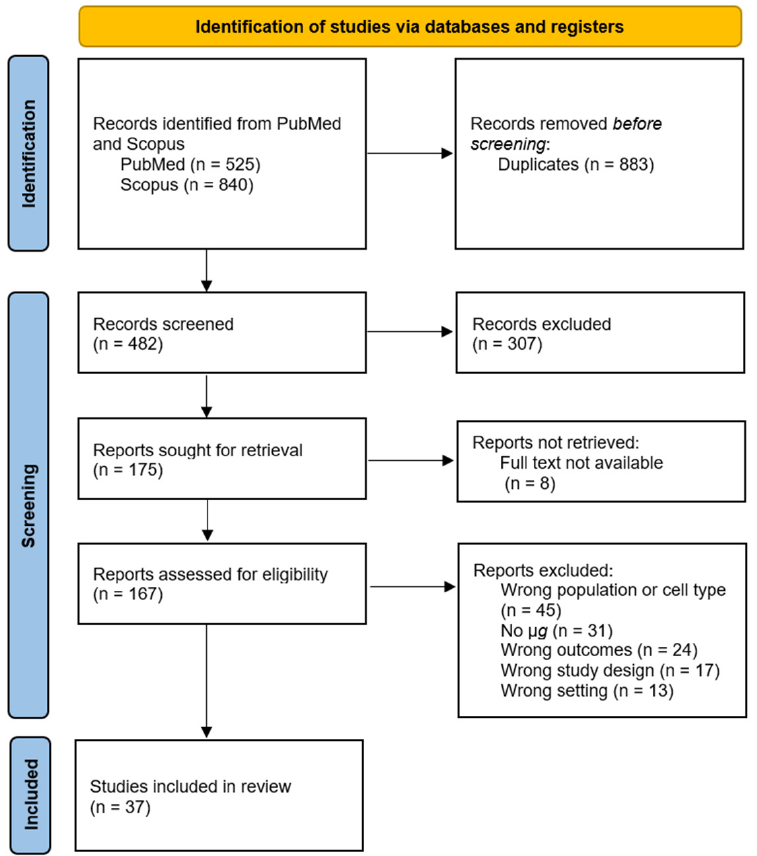
Figure 3. Search terms in PubMed.